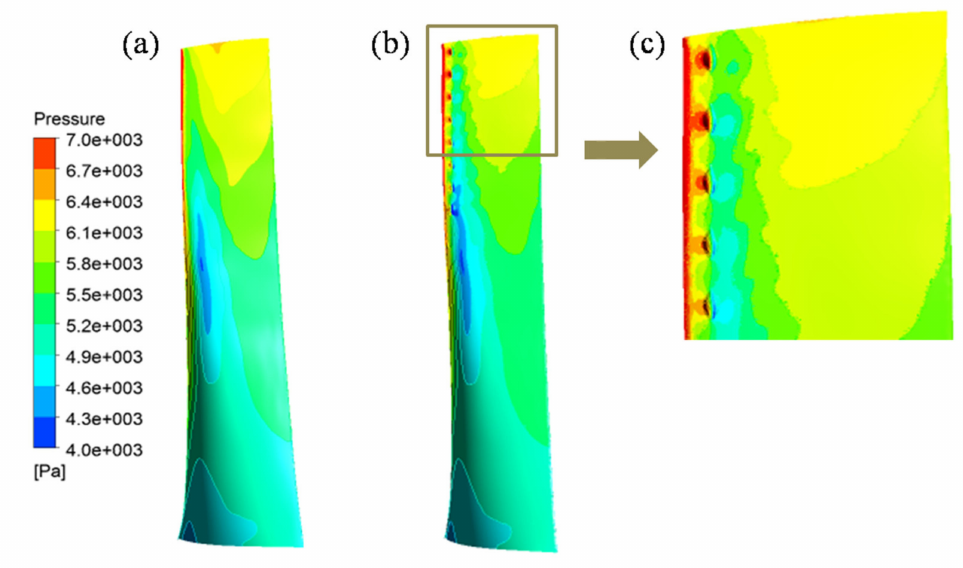
Figure 11. Static pressure distribution of suction side: ( a ) original blade, ( b ) modified blade, and ( c ) enlarge